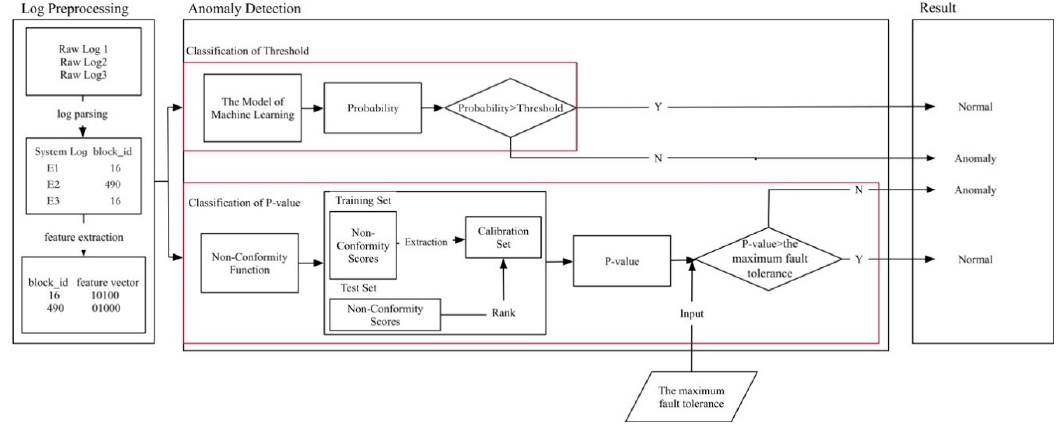
Figure 1. Framework of model.